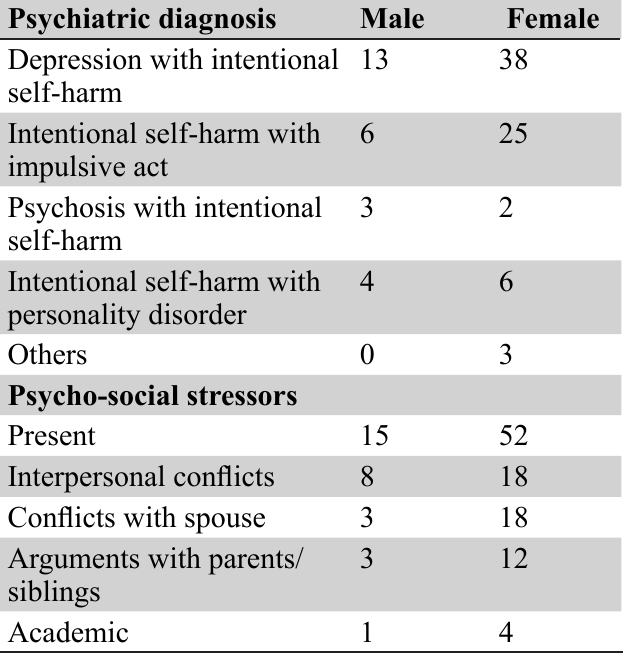
Table 3. Diagnosis and psychosocial stress